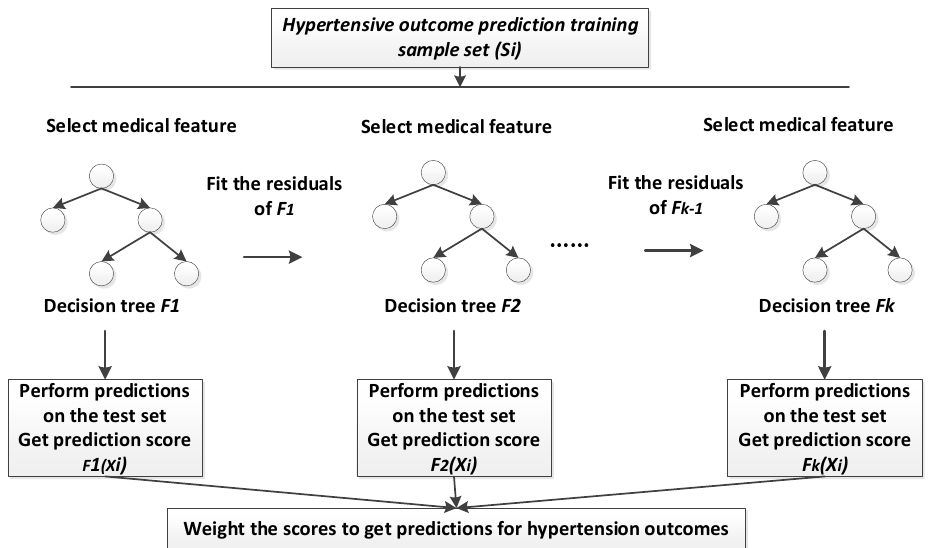
Figure 5. XGBoost-based Hypertensive Outcomes Prediction Modeling Process. Figure 6 is an example of modeling using XGBoost. Two decision trees are generated based on the two characteristics of maximum systolic blood pressure and 24-h average blood pressure. For determining whether an outcome occurs in a sample, there are corre- sponding scores on the leaf nodes of the two trees. The scores of the two trees are summed up, the score of “outcome occurrence” is 2.5, and the score of “no outcome occurrence” is 4, so it is judged that the sample would not have an outcome.